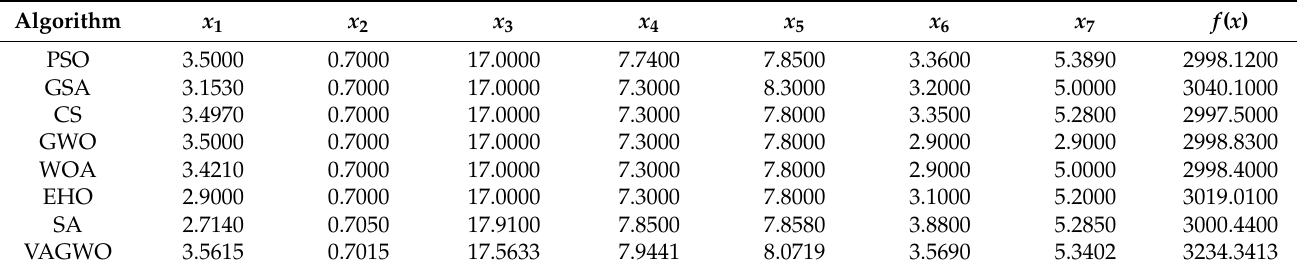
Table 18. Minimization results of speed reducer